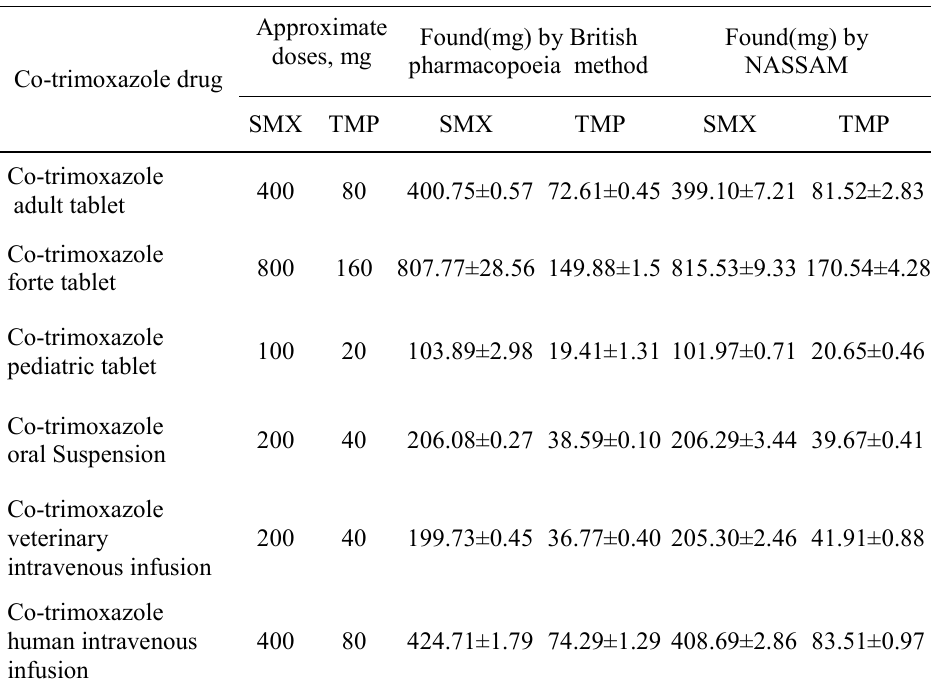
Table 5. Results of the replicate measurements for determination of SMX and TMP in some pharmaceutical formulations, expressed as X ± (tS.D.)/ N , for N=6 measurements and t (N-1=5)